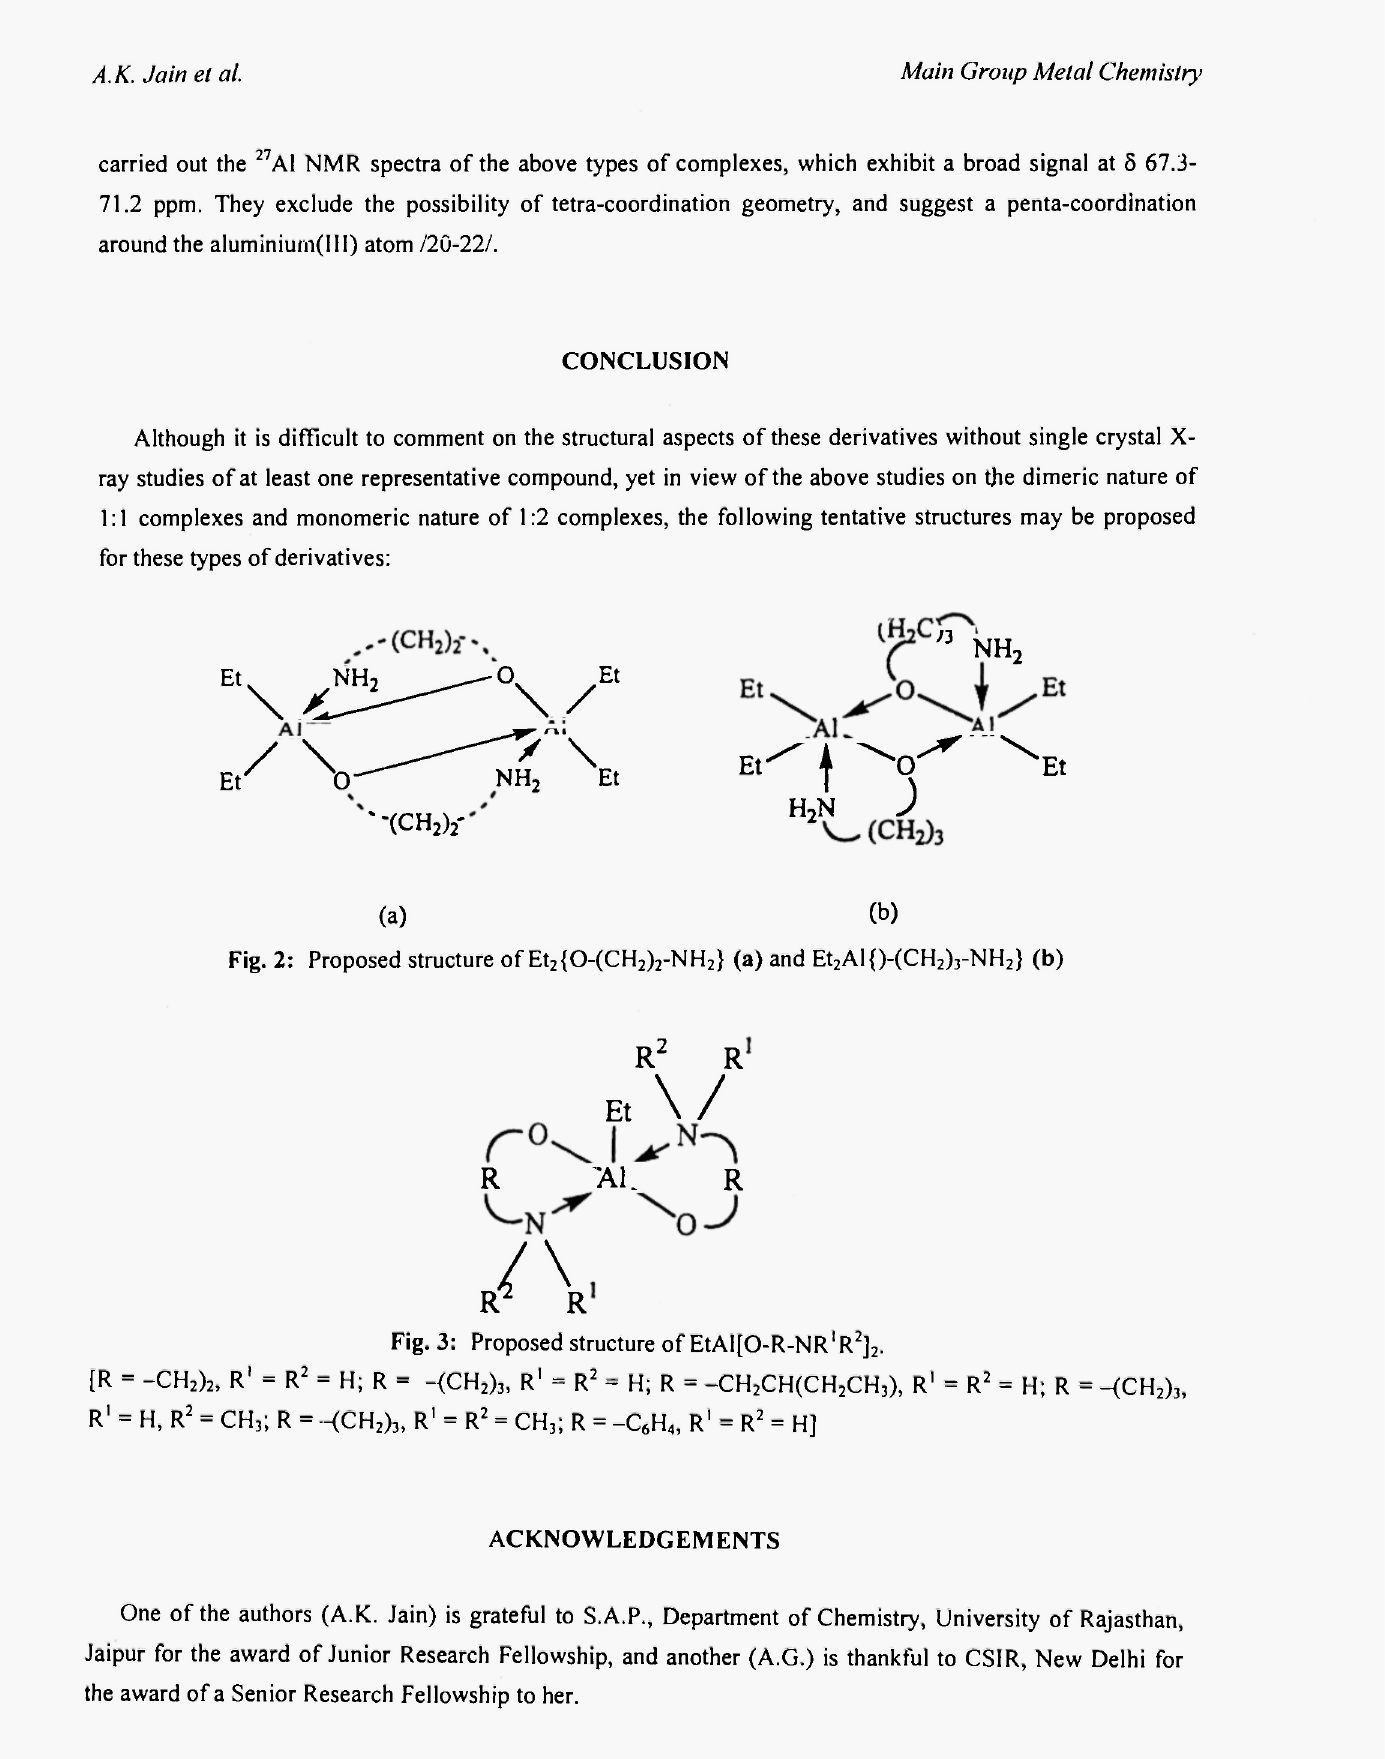
Fig. 2: Proposed structure of Et 2 {0-(CH 2 ) 2 -NH 2 }